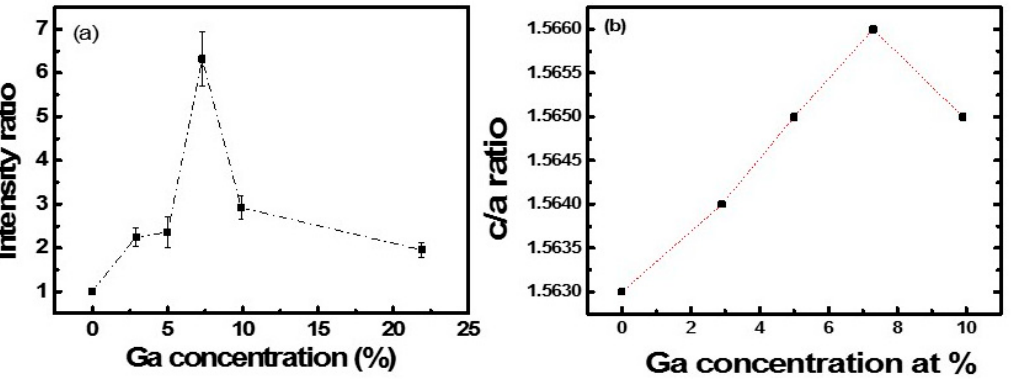
Figure 6. ( a ) Plot of the SHG intensity ratio between β = 90 ◦ and 0 ◦ (black dots) for GZO films as a function of Ga doping; ( b ) Plot of c / a ratio for GZO films as a function of Ga doping. Dotted lines are guide for the eye.